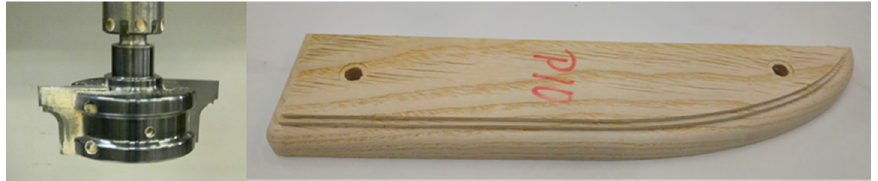
Figure 1. (Left)—Routing head with 2 tungsten carbide knives, (Right)—routing sample made of tree Figure 1. ( Left )—Routing head with 2 tungsten carbide knives, ( Right )—routing sample made of tree of heaven ( Ailanthus altissima ). of heaven ( Ailanthus altissima